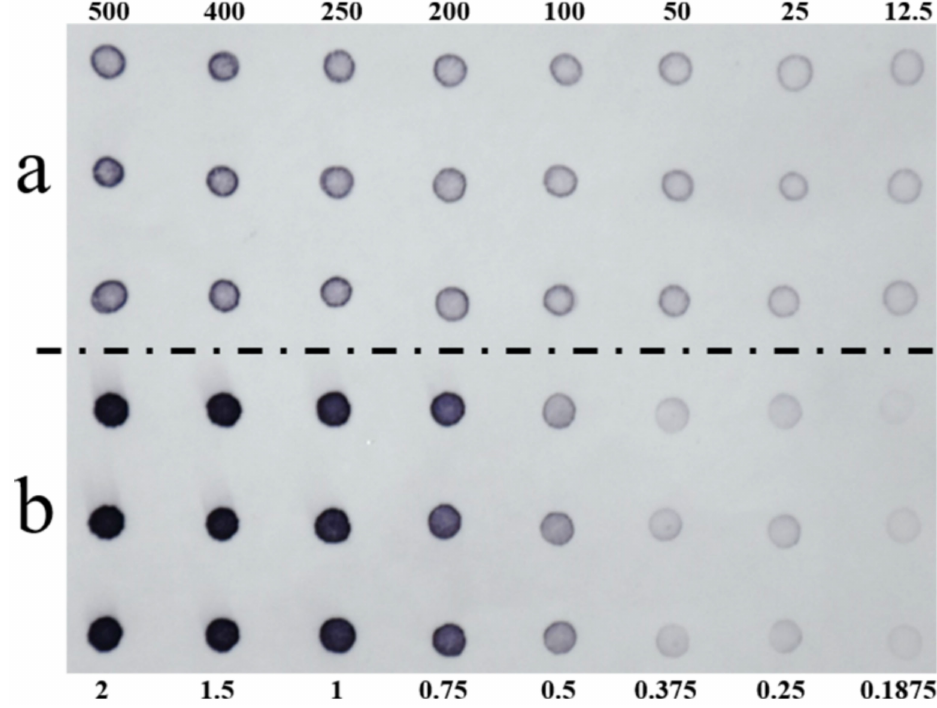
Figure 3. Estimation of the total copy number of Ty1- copia RT sequences in the P. purpureum genome. Serial dilutions (ng) of genomic DNA from P. purpureum row ( a ) and Ty1- copia RT sequences plasmids row ( b